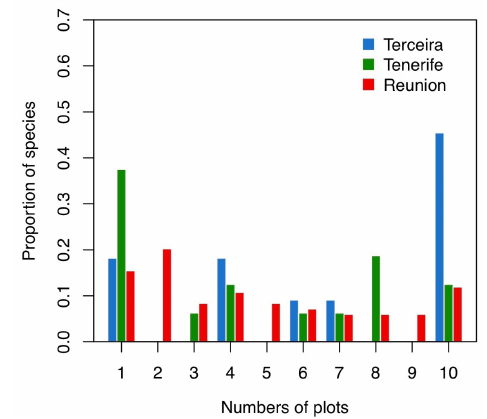
Figure 1. Frequency histograms showing the proportion of woody plants occupying the 10 plots in Terceira (Azores), Tenerife (Canaries), and Reunion (Mascarenes)